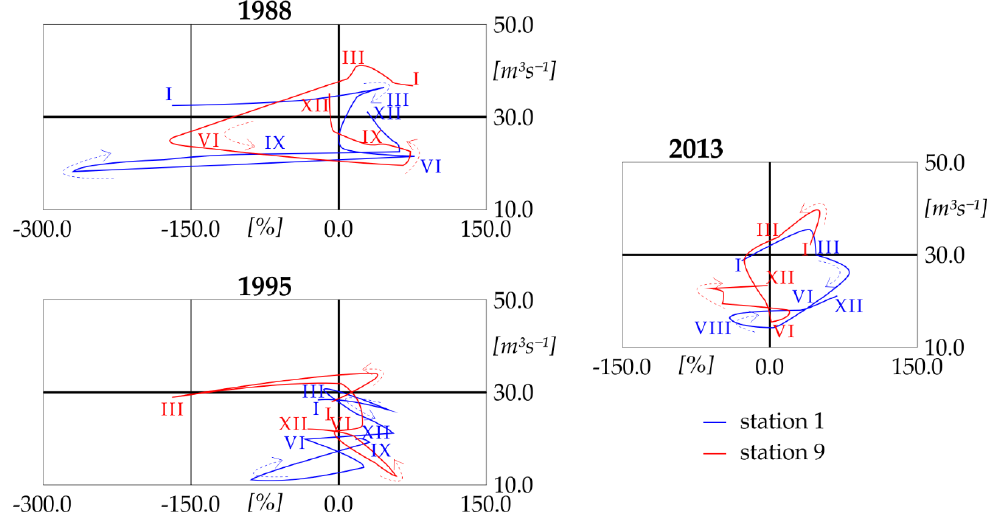
Figure 4. Relation of the discharge (Q) to the SSL balance inflowed to and outflowed from the Brda River reservoirs cascade (β) in selected years.